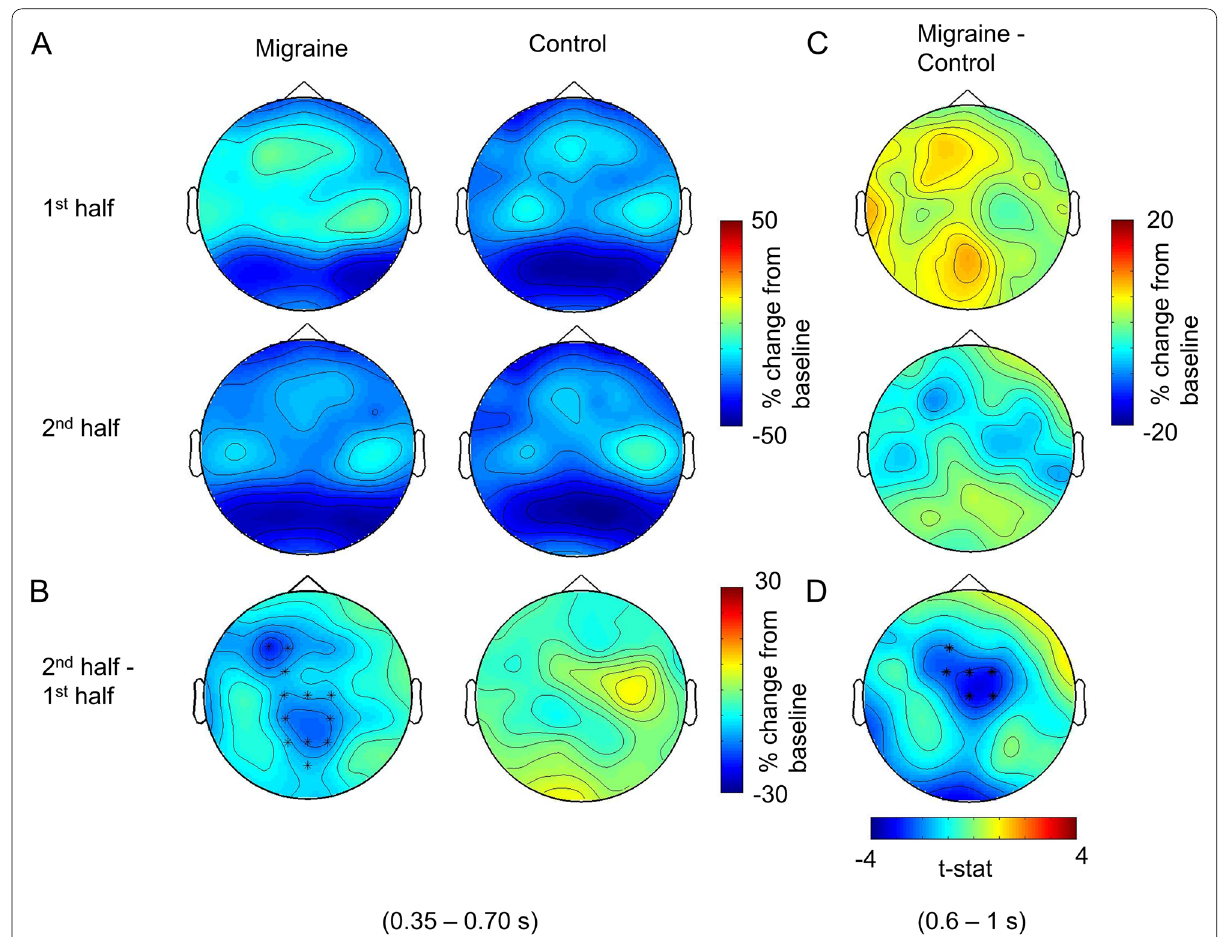
Fig. 8 The average post-stimulus alpha power change between 1st half and 2nd half of the experiment for MF condition. A Cluster-based permutation analysis on the post-stimulus interval (0 to 1 s after the MF grating onset) revealed an enhanced alpha suppression in 2nd half of the experiment for migraine between 350 and 700 ms after the stimulus onset. B The significant channels (highlighted with *) were distributed over the central-parietal regions. C There was no significant difference in alpha suppression between migraine and control for both 1st half and 2nd half of the experiment. D The average alpha suppression (600 – 1000 ms after the stimulus onset) for migraine was stronger in the 2nd half in the central-frontal region. The significant cluster (highlighted with an asterisk (*)) indicated the maximum differences in alpha suppression